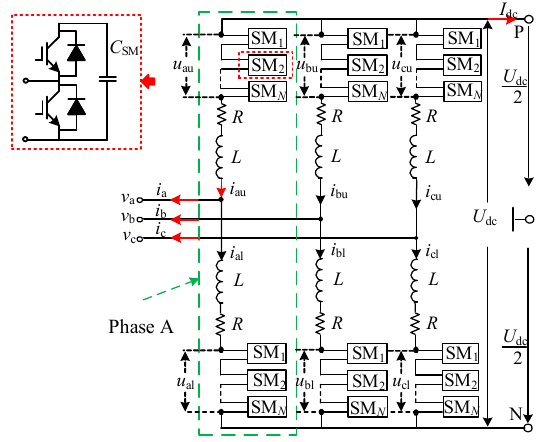
Figure 2. Basic structure of MMC.